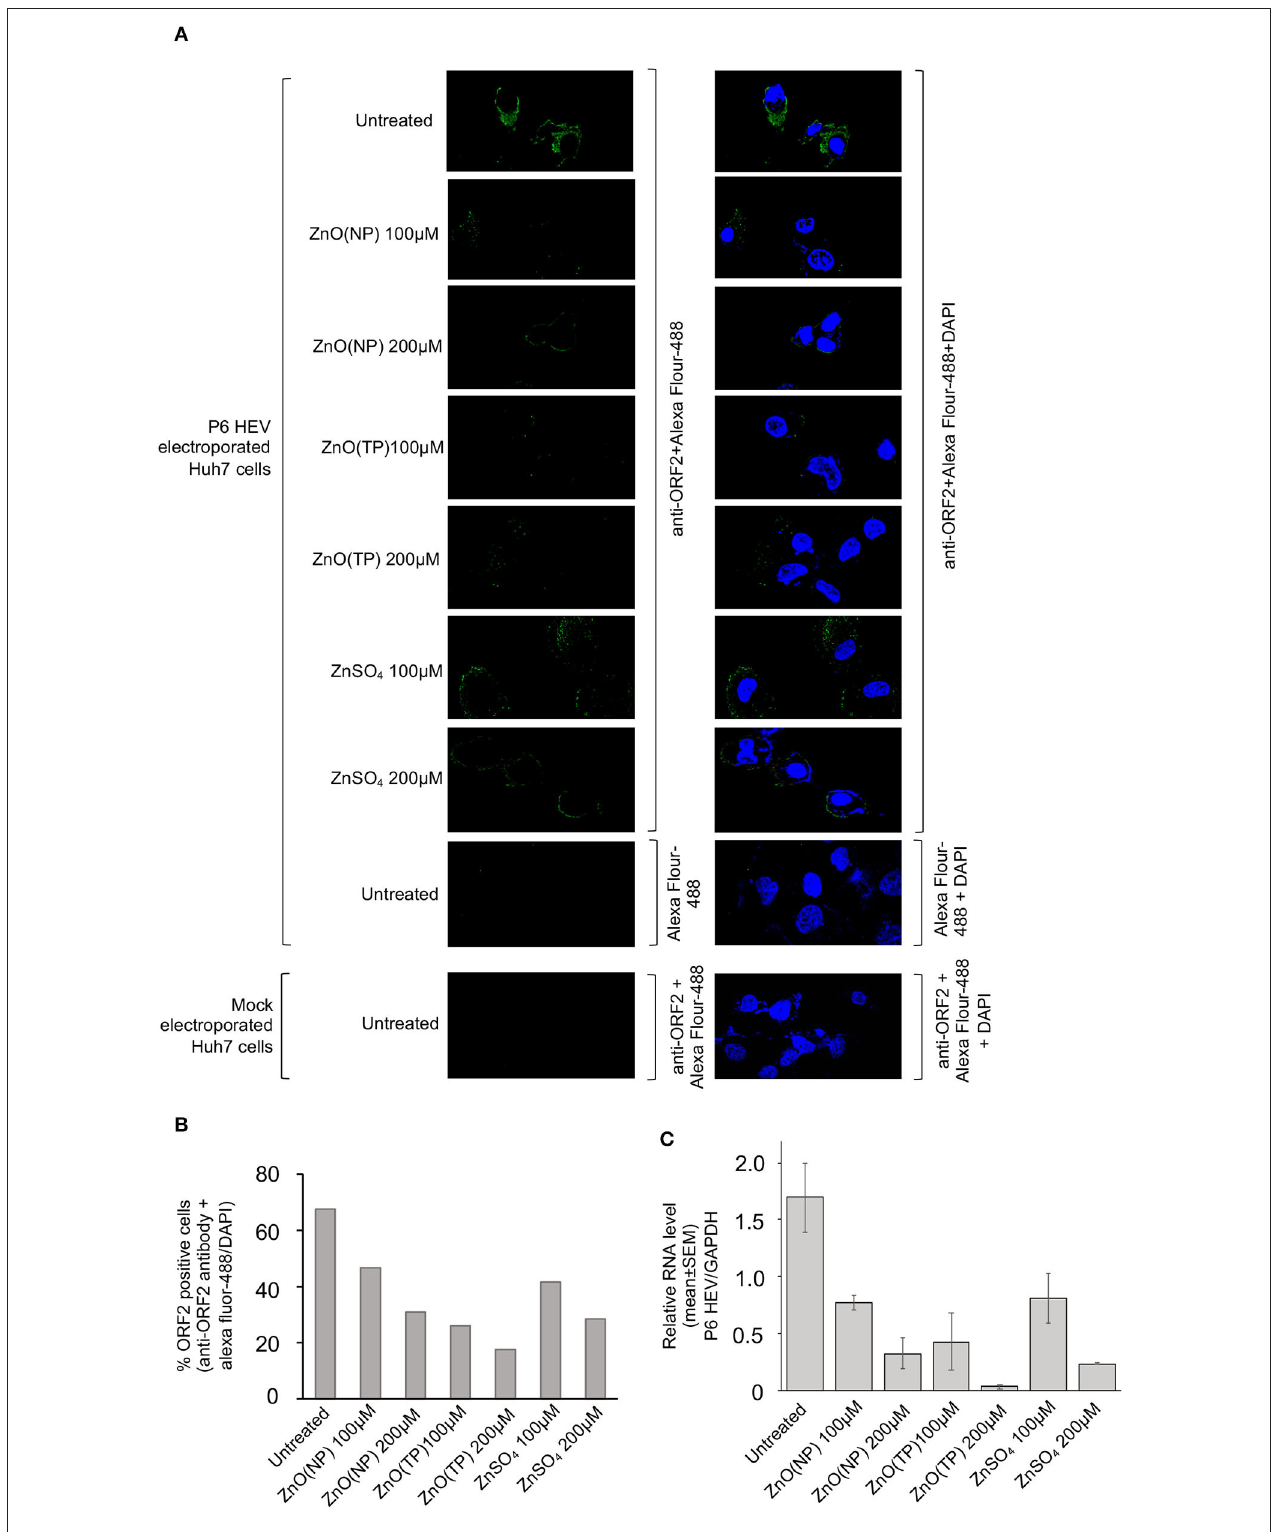
FIGURE 5 | Inhibition of P6 HEV replication by Zinc compounds. (A) Immunofluorescence assay-mediated detection of the P6 HEV ORF2 protein level in Huh7 cells electroporated with in vitro synthesized capped-genomic RNA of P6 HEV and treated for 24h with indicated concentration of ZnO(NP), ZnO(TP), and ZnSO 4 .